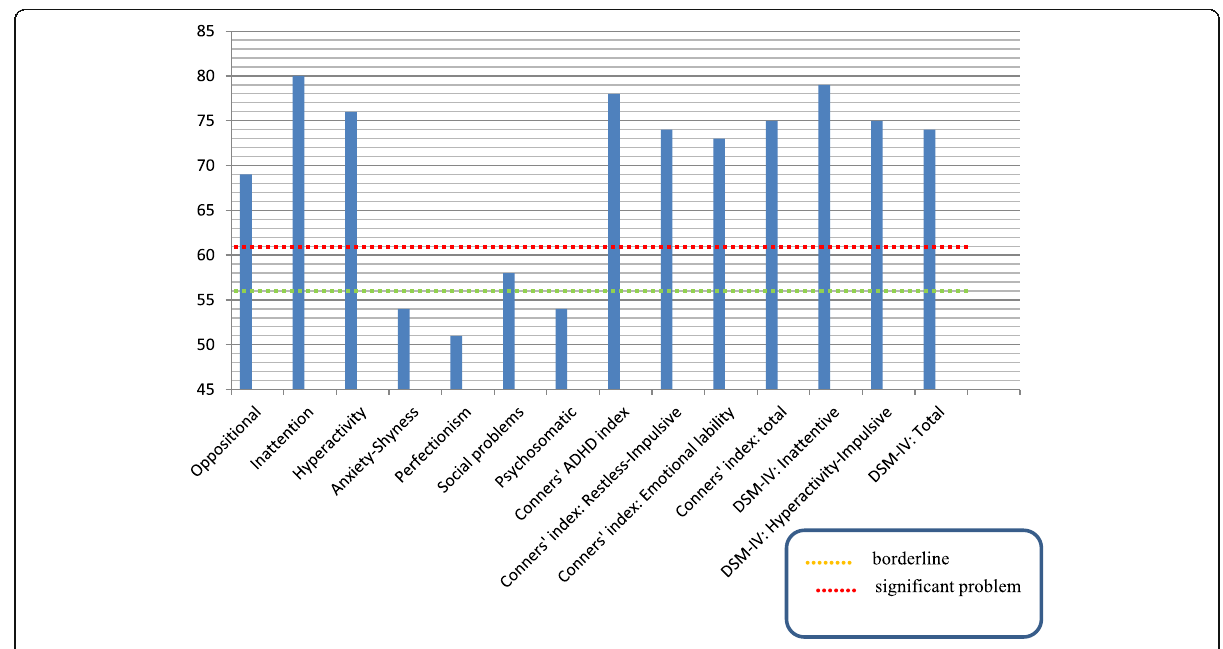
Fig. 1 Severity of ADHD symptoms as assessed by